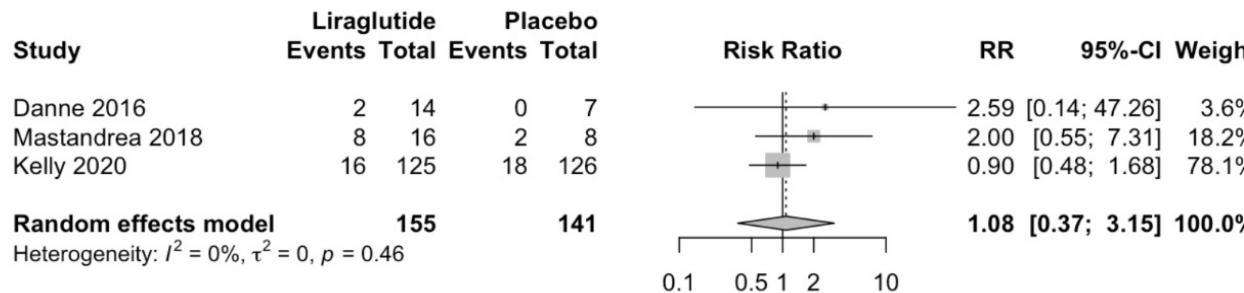
Figure 4. Effect of Liraglutide on Body Weight [30,31].